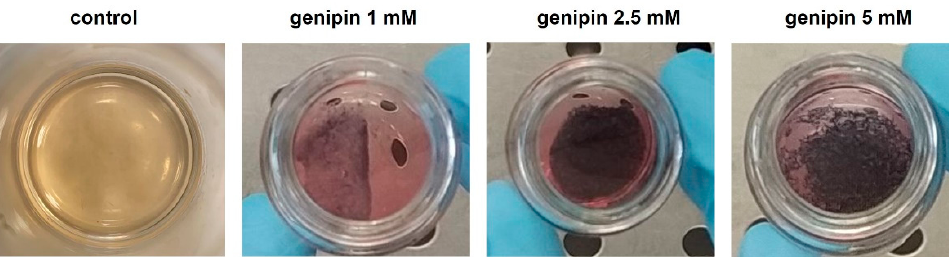
Figure 2. JellaGel™ hydrogels crosslinked with genipin at different concentrations. One representative sample for the control (no genipin) and for each genipin concentration is shown. The dark structures visible in the images correspond to the collagen gel networks, formed due to the bonds established between the collagen chains.